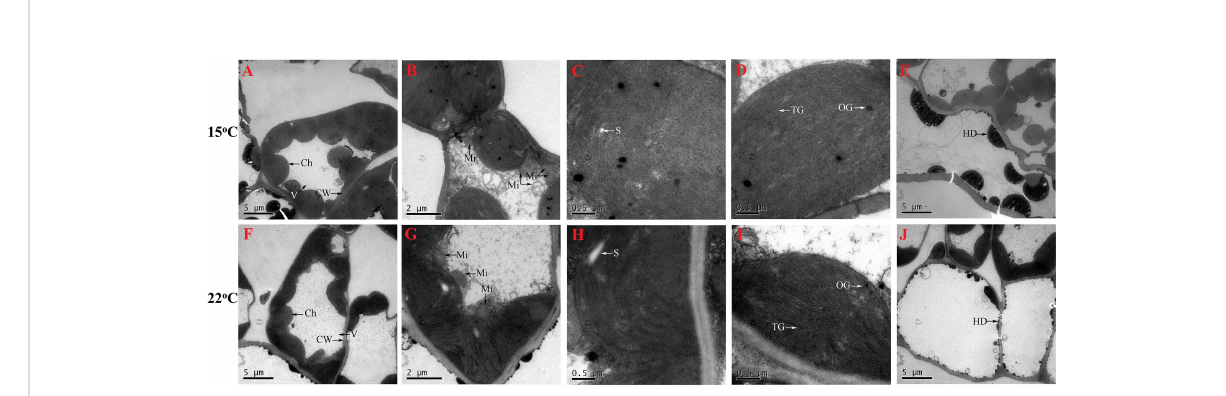
FIGURE 4 Cell ultra-structure for seedlings grown at 15 (A – E) and 22°C (F – J) . Ch, chloroplast, CW, cell wall; Mi, mitochondria; HD, hemispherical droplets; OG, osmiophilic granule; S, starch grain; TM, thylakoid grana; V,